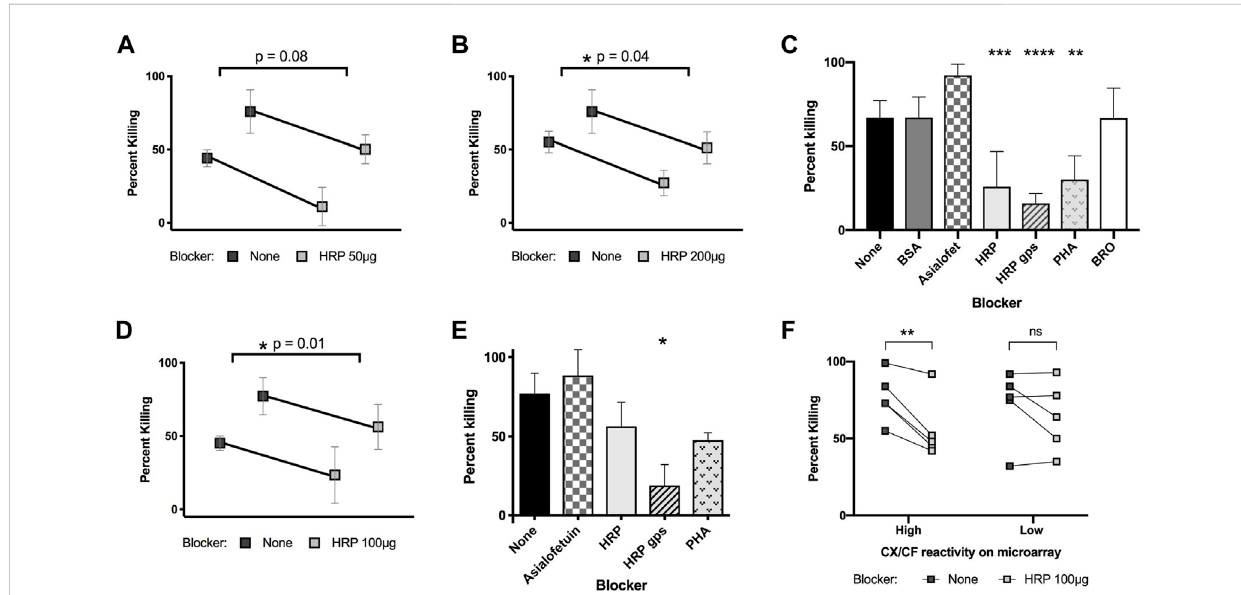
FIGURE 5 Killing of schistosomula by infected rat and rhesus serum with glycoprotein blockers. 3 h schistosomula were incubated with active guinea pig complement and pooled rat serum (A – C) or rhesus serum (D, E) from secondary infection, which had been pre-incubated with the indicated blocking glycoproteins or glycopeptides. Percentage of non-viable out of total schistosomula were quanti fi ed at 48h. Paired t-tests were performed for sera with orwithoutHRPblockingwiththeindicated p -values (A,B,andD) .In (C,E) ,concentrationsofblockerare50 μ g(asialofetuin,BSA,HRP,PHA,BRO)or 25 μ g (HRP glycopeptides). One-way ANOVA with Dunnett ’ s multiple comparisons was performed to compare each blocker to control (no blocker) * p < 0.05; ** p < 0.01, *** p < 0.001 **** p < 0.0001. In (F), 10 samples from individual infected rhesus monkeys were strati fi ed by high ( > 1,000 RFU) or low ( ≤ 1,000 RFU)reactivitytoCX/CFepitopeon theDSA,andtested forschistosomulakillingwith orwithoutHRPblocking(100 μ g/well).2-way ANOVA with Sidak ’ smultiplecomparisonsshowedsigni fi canteffectofblockingforrhesussampleswithhighCX/CFreactivity,butnotforblockingofsampleswithlow CX/CF